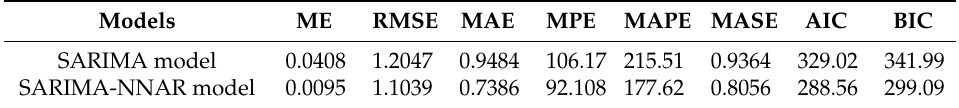
Table 2. Prediction accuracy measures of scale-dependent errors on both models.